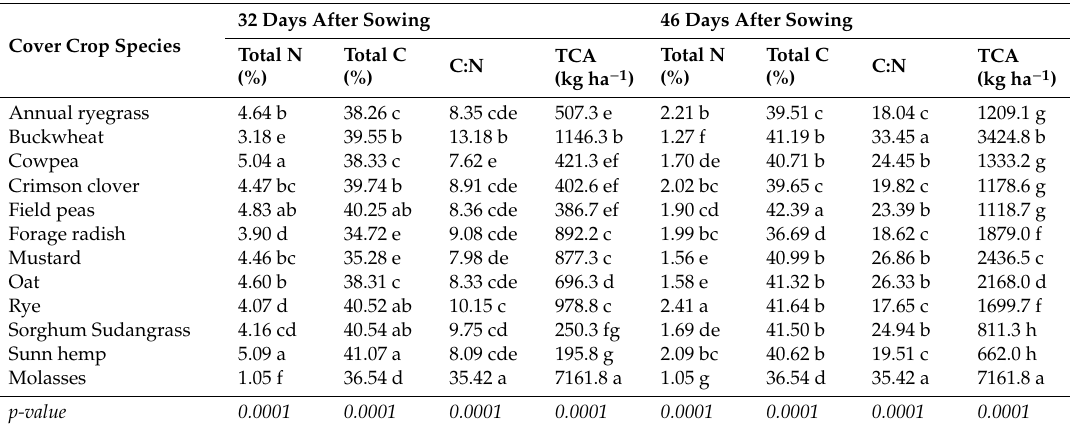
Table 3. Total carbon (C), total nitrogen (N) content, C:N ratio, and total carbon applied (TCA) amending the soil with the above-ground portion of selected cover crop species and molasses 1